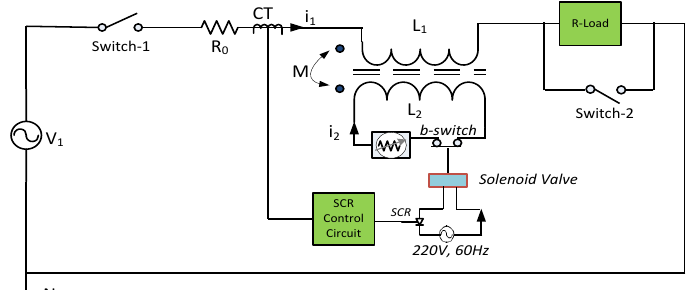
Figure 4. Transformer type SFCL with load in single phase circuit.